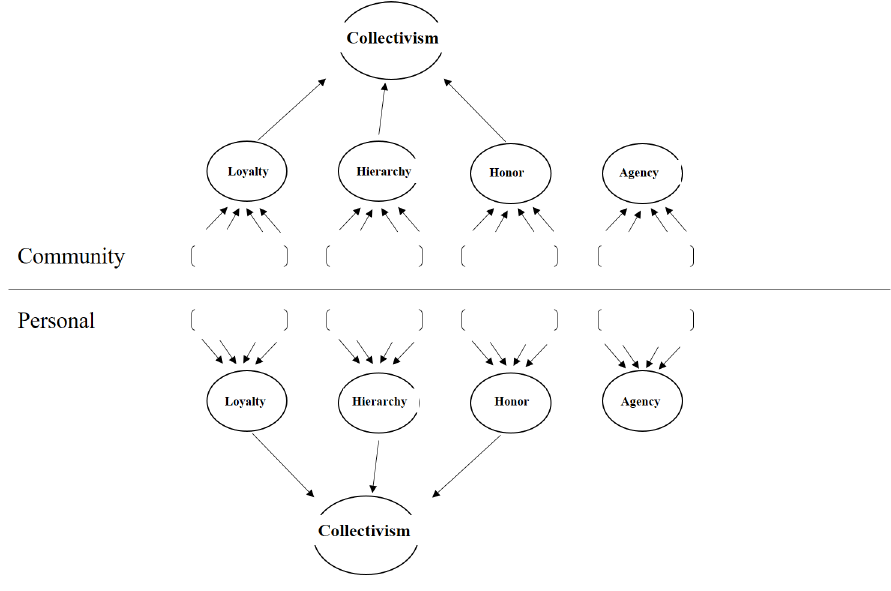
Fig 1. Structure of Community